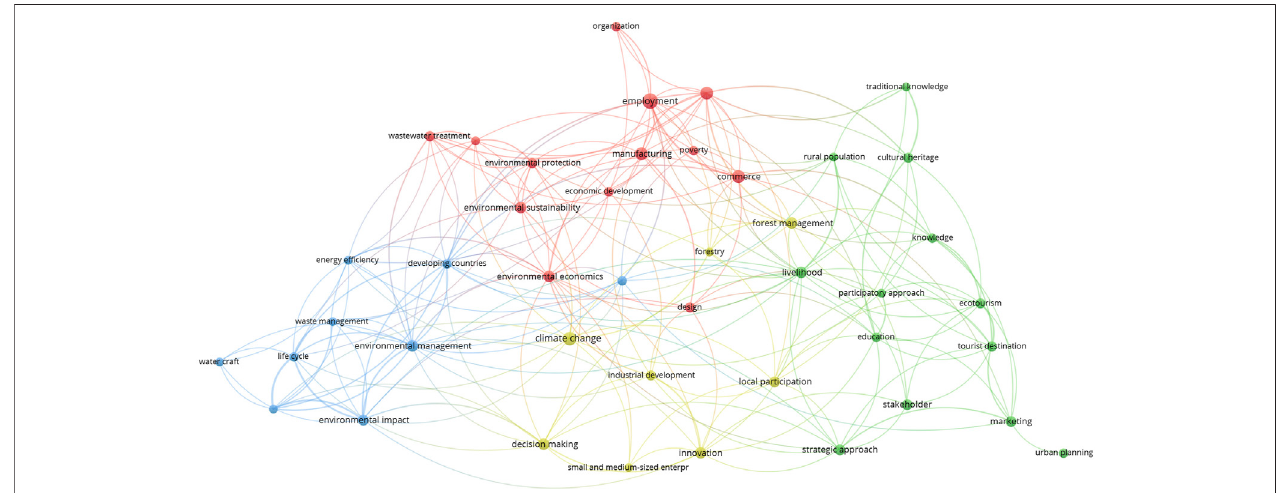
FIGURE 8 | Keyword network on sustainable crafts for the period 2015 – 2021. Source: Authors ’ own.